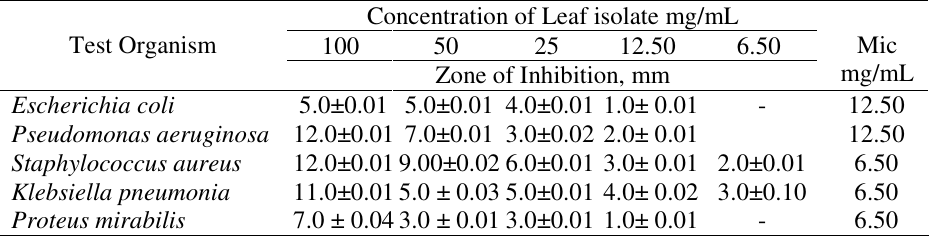
Table 3. Minimum inhibitory concentration of Compound 1 Isolated from leaf of A. cordifolia on the pathogens,